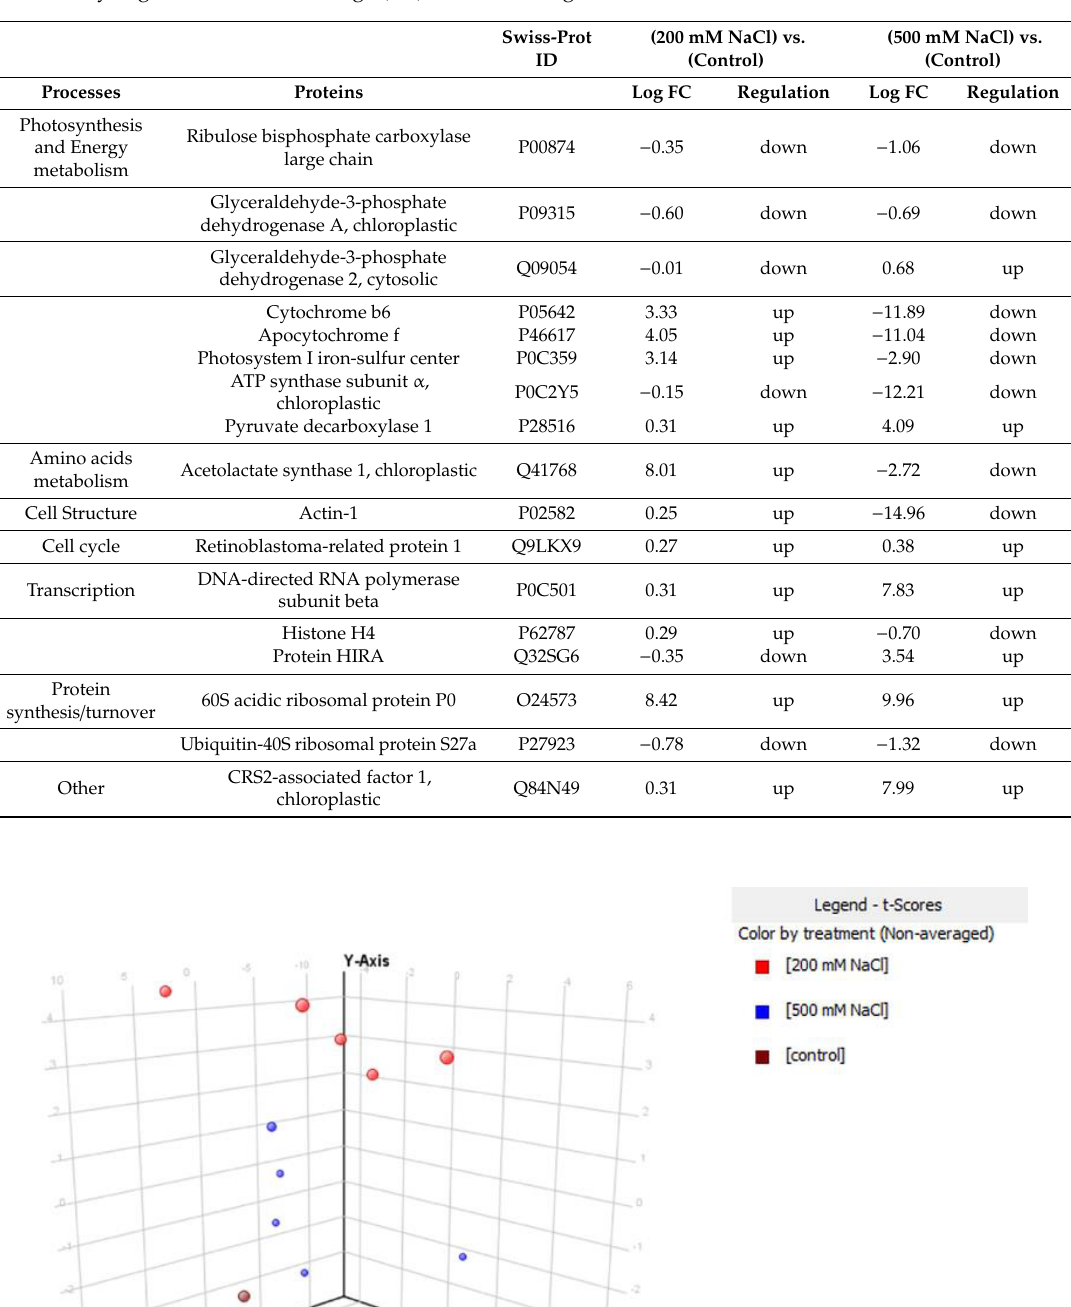
Table 2. Discriminant proteins in Suaeda maritima shoots under either 200 mM and 500 mM NaCl salinity, together with fold-change (FC) values and regulation.